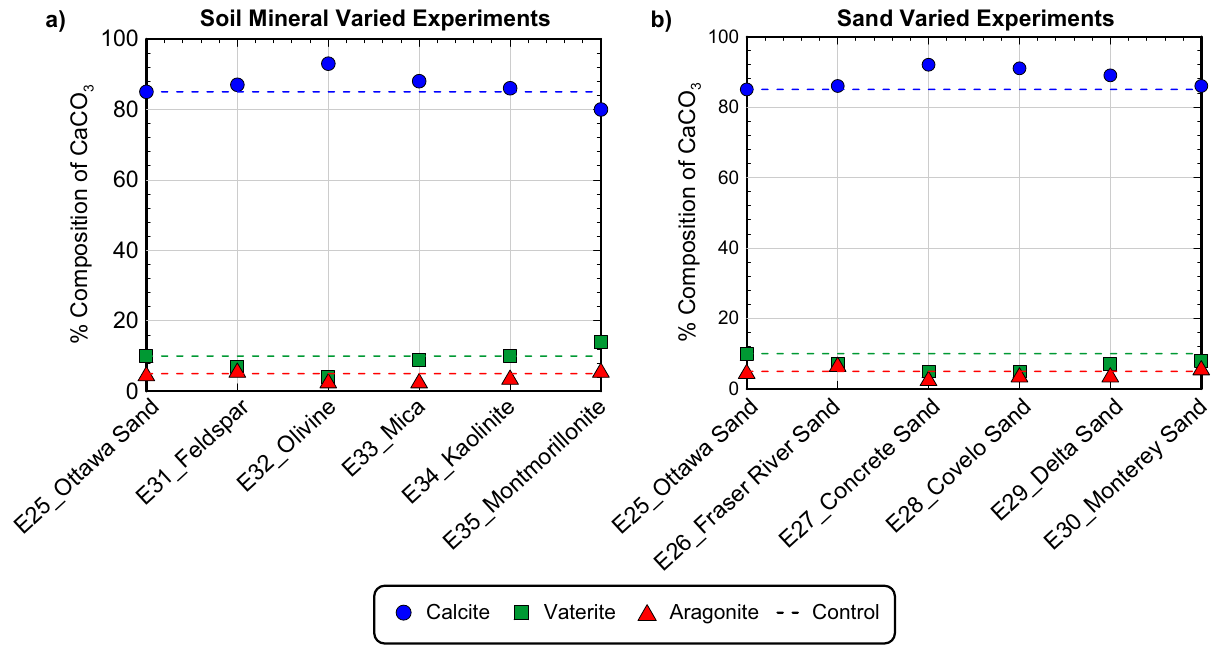
Figure 11. Relative CaCO 3 mineral content percentages for ( a ) soil mineral varied experiments and ( b ) poorly- graded sand varied experiments determined from S-Q analysis of XRD diffraction